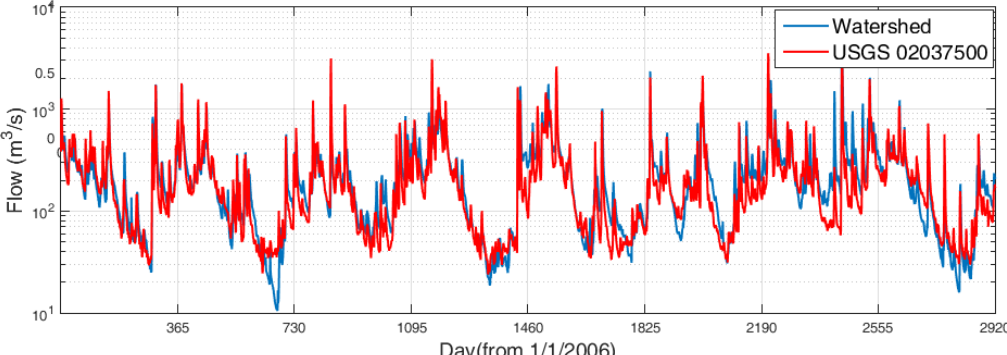
Figure 8. Comparison of freshwater discharge between USGS data (USGS02037500) and watershed model simulation output at Richmond.